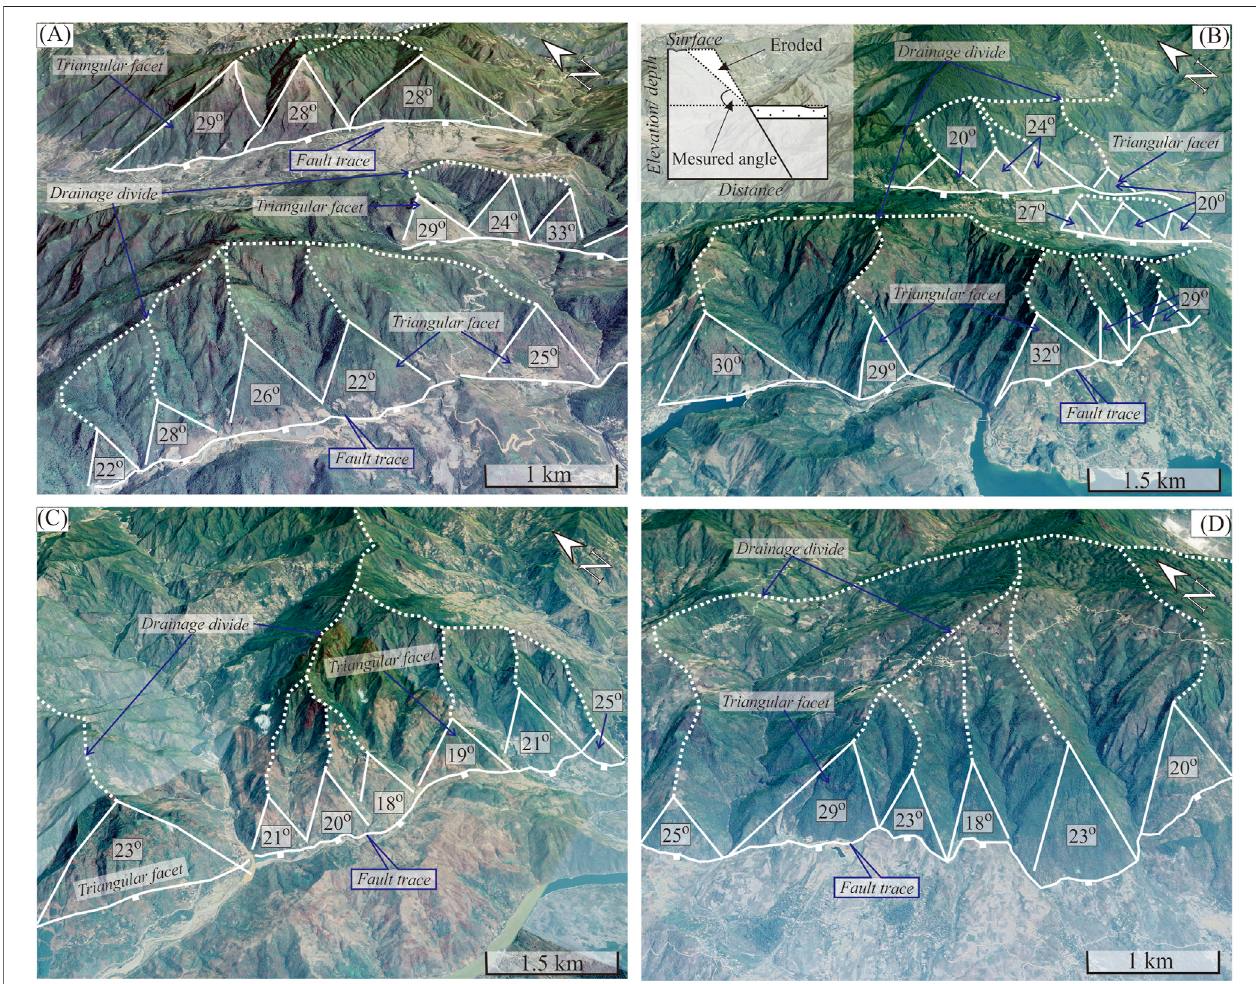
FIGURE 6 | Satellite imagery (downloaded from Google Earth, December 18, 2020) shows an impressive range-front scarp with triangular facets on the southwestern fl ank of Tule area. While line with barbs indicates inferred normal fault. White line presents triangular facets. White dash line shows drainage divides. Number refers to slope value (in